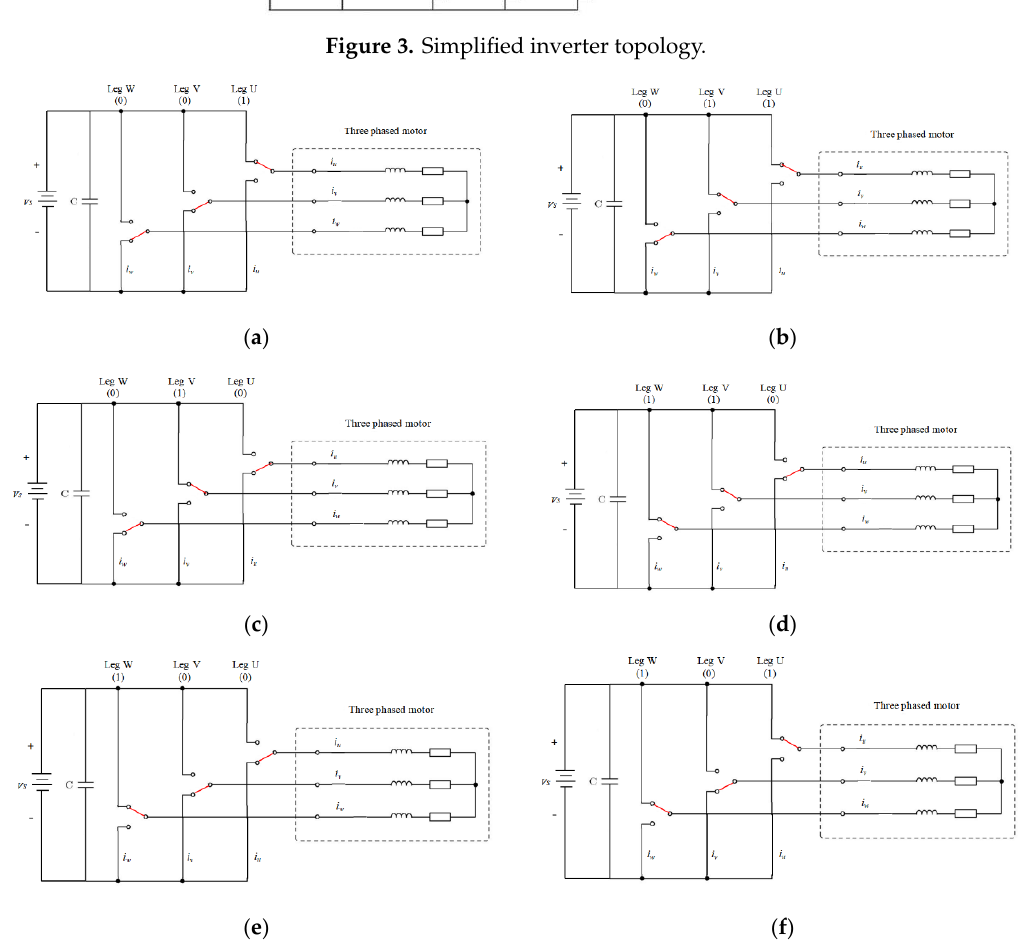
Figure 4. SVPWM of V 1 –V 6 . ( a ) SVPWM of V1 (0,0,1); ( b ) SVPWM of V2 (0,1,1); ( c ) SVPWM of V3